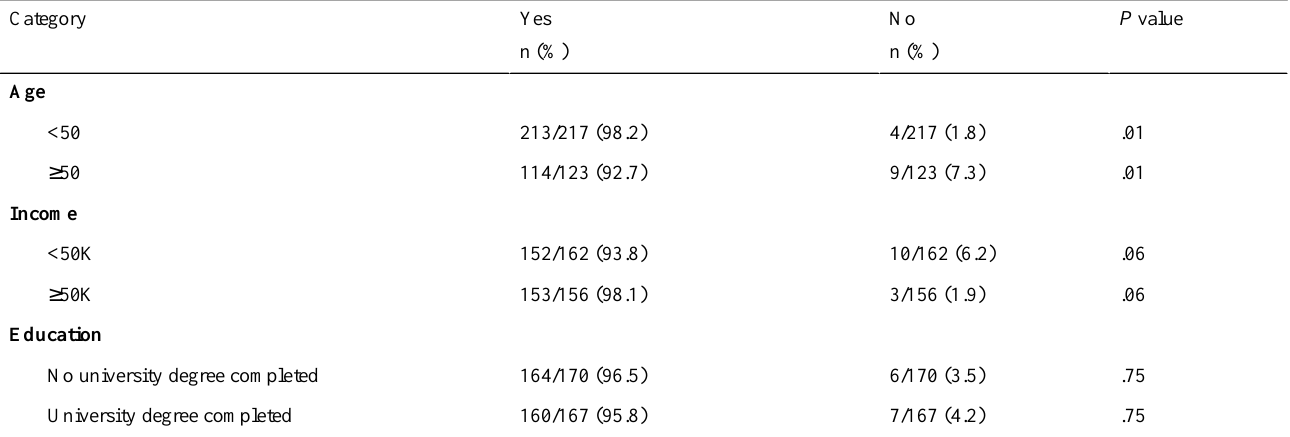
Table 4. Likelihood to recommend by patients. a